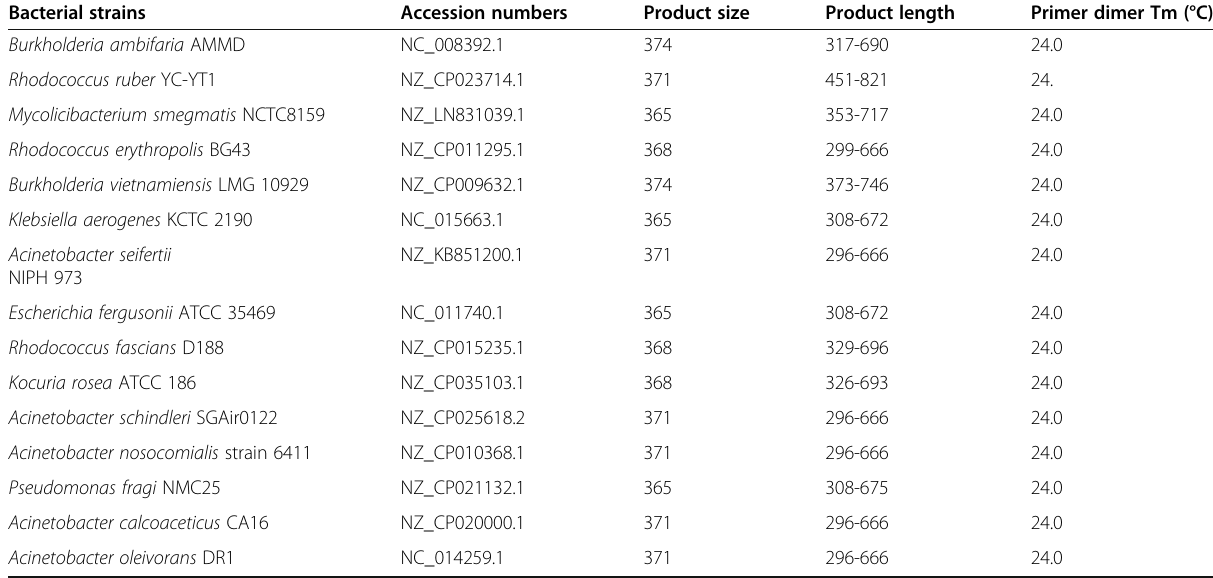
Table 11 In silico PCR analysis of primer pair catAf/catAr with targeted sequences Bacterial